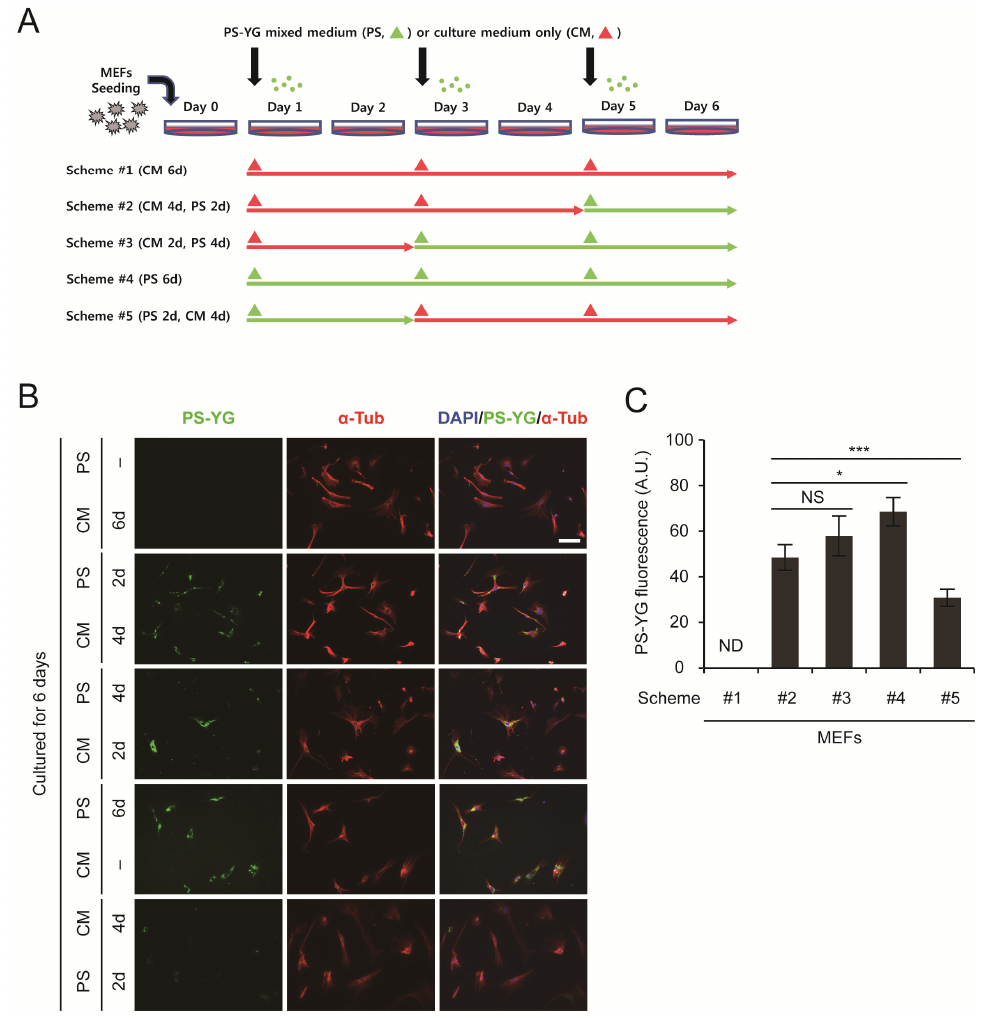
Figure 4. Clearance of PS nanoplastics from the cytoplasm of MEFs. ( A ) Schematic representation of experiments. ( B ) MEFs were treated with 100 nm PS-YG nanoplastics at 200 mg/L for 2 to 6 days. Cells were subjected to immunofluorescence analysis using an anti- α -tubulin ( α -Tub) antibody and DNA was visualized with DAPI. Direct fluorescence from PS-YG nanoplastics was also visualized. ( C ) Quantitative analysis of PS-YG fluorescence levels in (B). Green fluorescence levels in all α -Tub-positive cells in the field were determined and expressed as the means ± SEM from the number of cells shown. PS, PS-YG mixed medium. CM, culture medium only. * p < 0.05; *** p < 0.001 between two groups, as indicated by horizontal bars. ND, not determined. NS, not significant. Scale bar, 100 μ m.